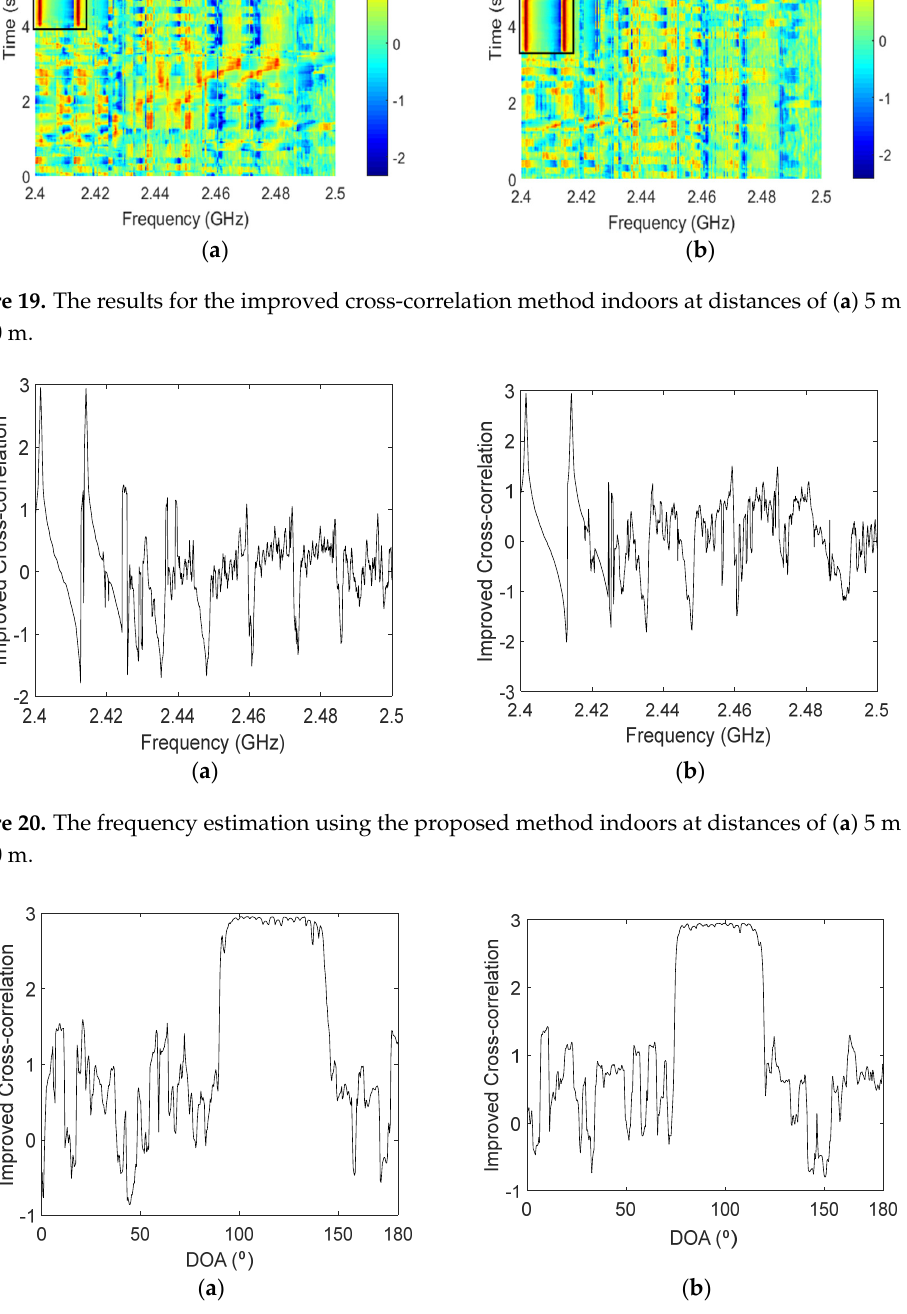
( a ) ( b ) Figure 22. The results for the HOC method indoors at distances of ( a ) 5 m and ( b ) 10 m. ( a ) ( b ) Figure 23. The result for the CFAR method indoors at distances of ( a ) 5 m and ( b ) 10 m.